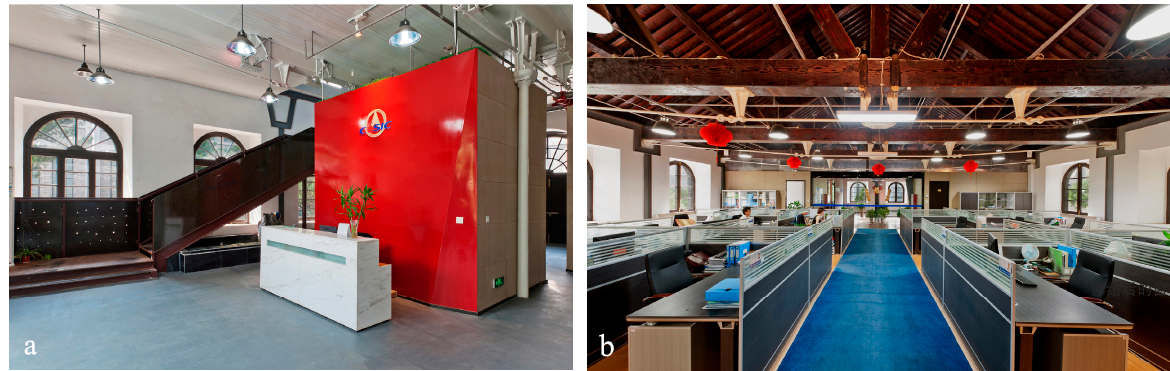
Figure 18. Interior space of the first floor ( a ) and second ( b ) floors after renovation. Pictures by Y.W.